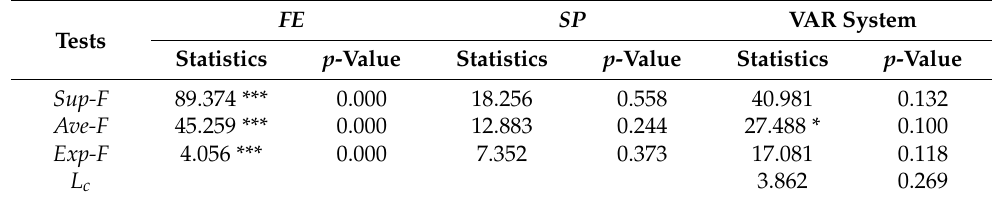
Table 3. The results of parameter stability